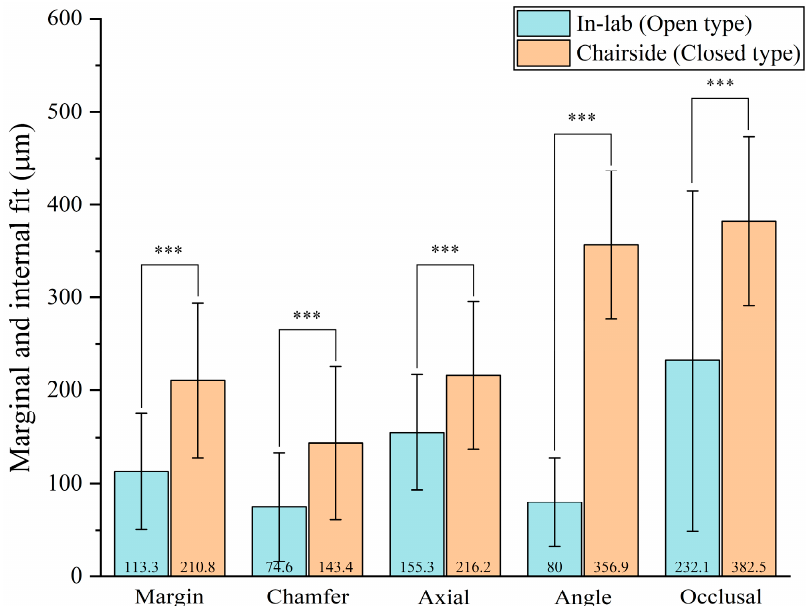
Figure 6. Comparison of the marginal and internal fit mean values by digital workflows. ***, Significant ( p < 0.001). Table 1. Comparison of the marginal and internal fit according to digital workflows.